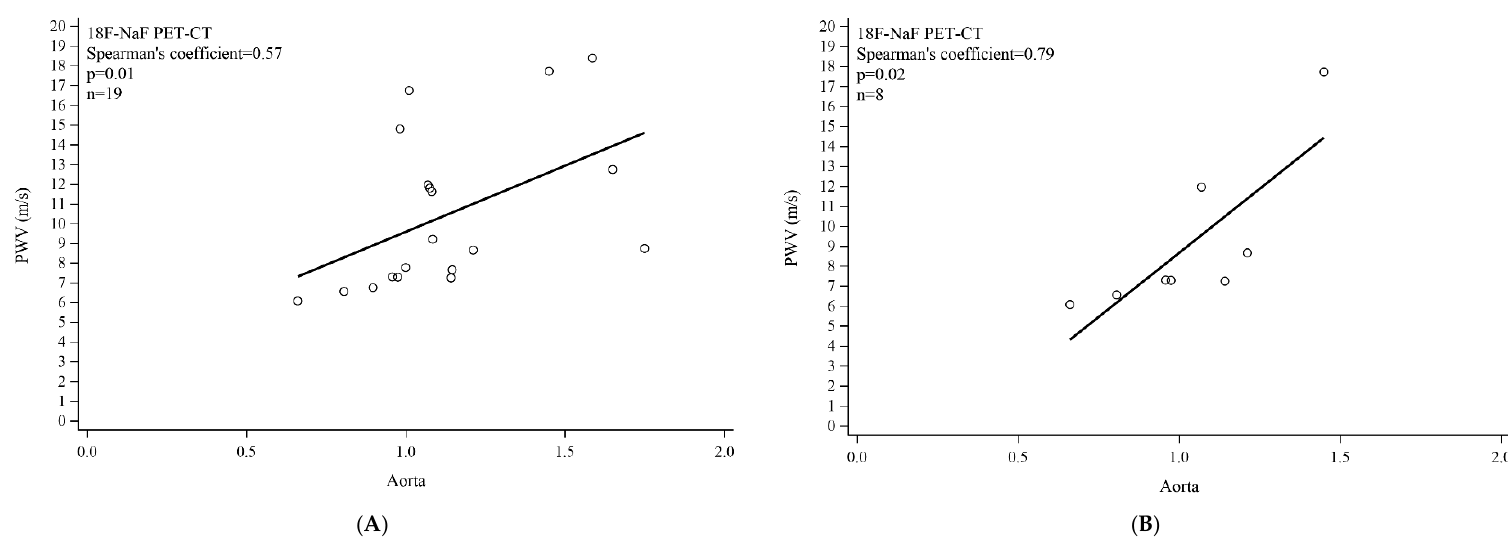
Figure 4. Correlation between 18F-NaF uptake and pulse wave velocity (PWW) in aorta. ( A ) All PXE patients; ( B ) PXE patients with calcium score (CS) = 0HU. Table 3. Correlation between aorta wall 18F-NaF uptake and PWV adjusted to SBP, DBP and both together. PXE Patients ( n = 19)